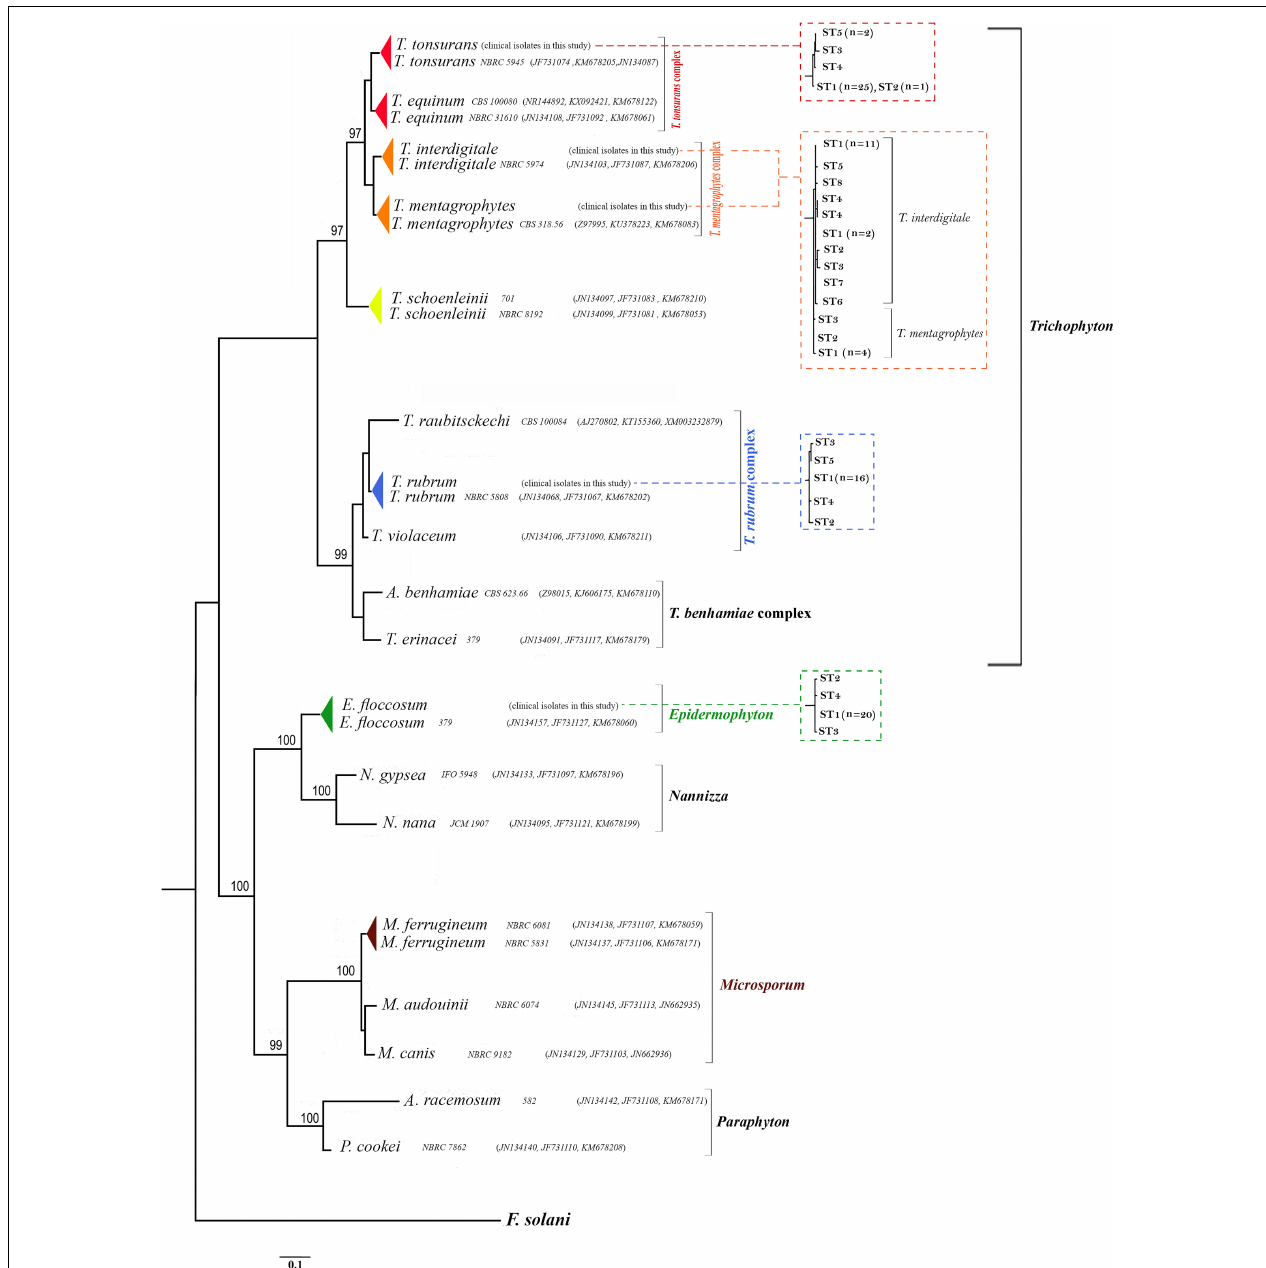
FIGURE 2 | Phylogenetic relationships within dermatophytes. The consensus trees constructed by RAxML analysis from the combined three-locus ITS, BT2 , and TEF-1 α from clinical isolates and dermatophytes species available in the GenBank. The accession number profile was written in order ITS, BT2 , TEF-1 α loci. F. solani was used as an outgroup to root the dendrogram. The bootstrap value greater than 95% is shown above the branches. Also, the relationship between STs and taxa in RAxML analyses for the 99 dermatophyte species used in this study from the combined three-locus ITS, BT2 , and TEF-1 α is shown in the dot-box